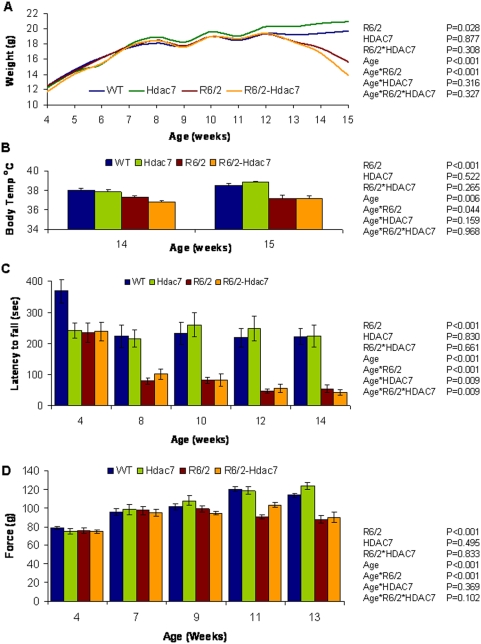
HDAC7 genetic reduction does not alter R6/2 physiological or behavioural phenotypes.The R6/2 phenotypes (A) weight loss, (B) hypothermia, (C) impaired RotaRod performance and (D) reduced grip strength are not ameliorated by genetic knock-down of Hdac7 expression. Error bars represent S.E.M. Shown to the right of each graph are the P values arising from GLM repeated measures ANOVA analysis of the data.